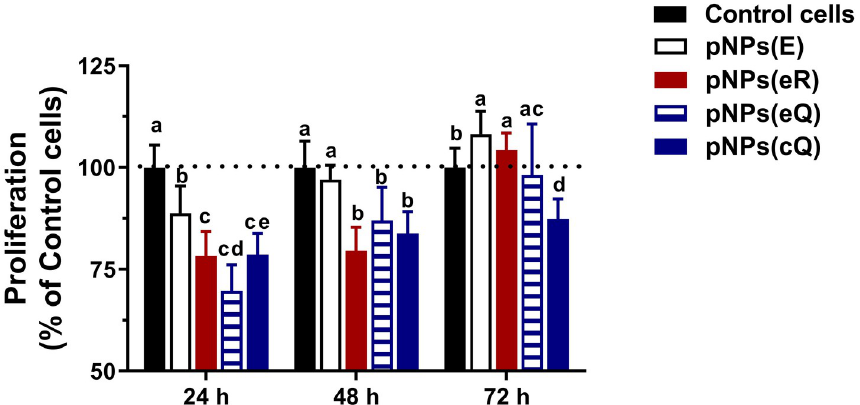
Fig 5. Rat aortic smooth muscle cells loaded for 2 hours with empty pNPs (pNPs(E)), entrapped quercetin (pNPs (eQ)), covalent quercetin (pNPs(cQ)) and entrapped rhamnazin (pNPs(eR)) exhibit reduced rates of cell proliferation at 24, 48 and 72 hours after washing. Cell proliferation was assessed by determining the incorporation of BrDU compared to control cells treated with no pNPs. Data are means ± SD for n = 8. Two-way ANOVA revealed a significant effect of treatment. Means denoted by unlike letters represent significant differences for the same time point, revealed using Bonferroni’s post-hoc tests. Dotted line represents the response for control cells treated with no pNPs, denoted as